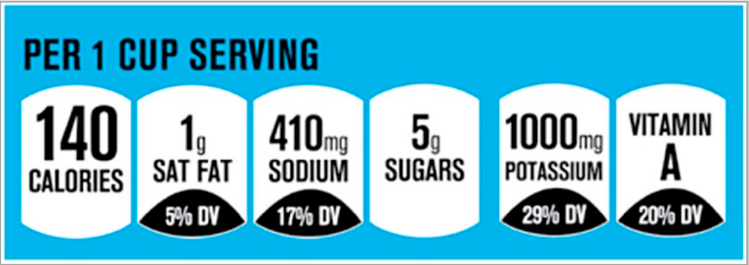
Daily values are provided for all nutrients except sugar. Figure A2. Facts-Up-Front (USA) provides the energy content alone or together with saturated fat,